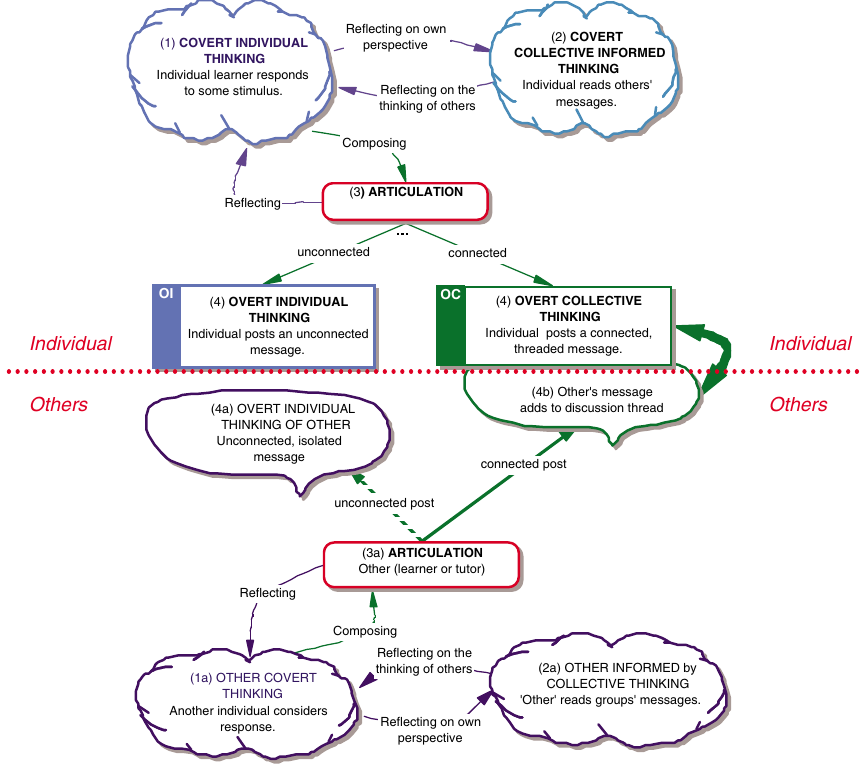
Figure 7. A framework for learning through online